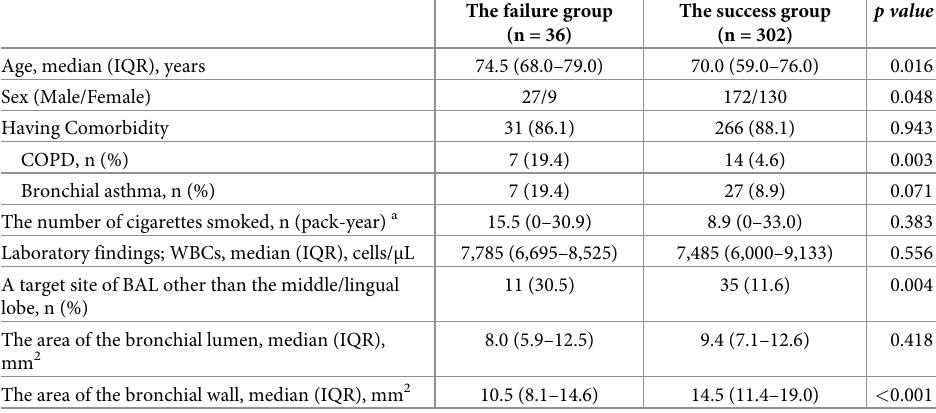
Table 1. Comparisons between the failure group and the success